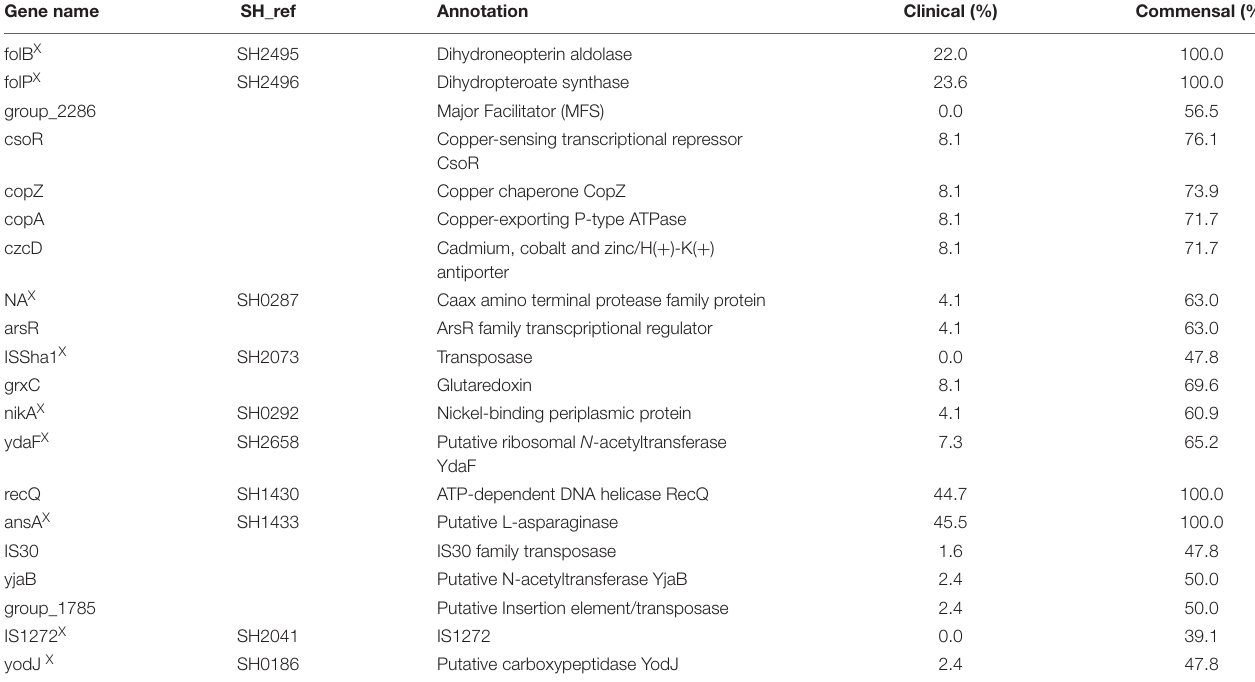
TABLE 4 | Genes and gene versions enriched in 46 commensal isolates, sorted by